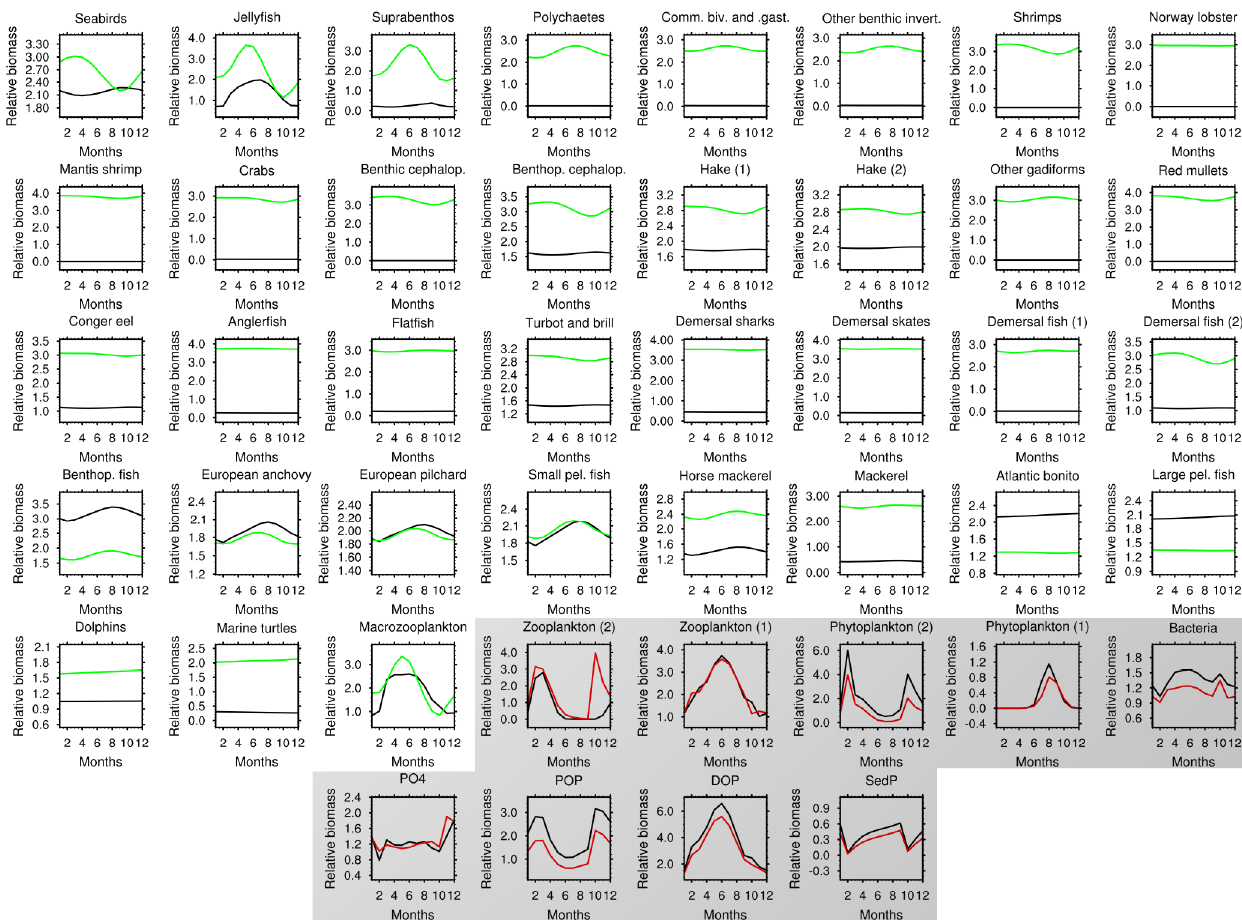
Figure 6. Monthly results of the final year in a 10-year simulation of the coupled (black lines) model versus simulations of uncoupled EwE 6.5 (green lines for HTL variables – unshaded boxes) and uncoupled biogeochemical (red lines for LTL variables – grey shaded boxes)